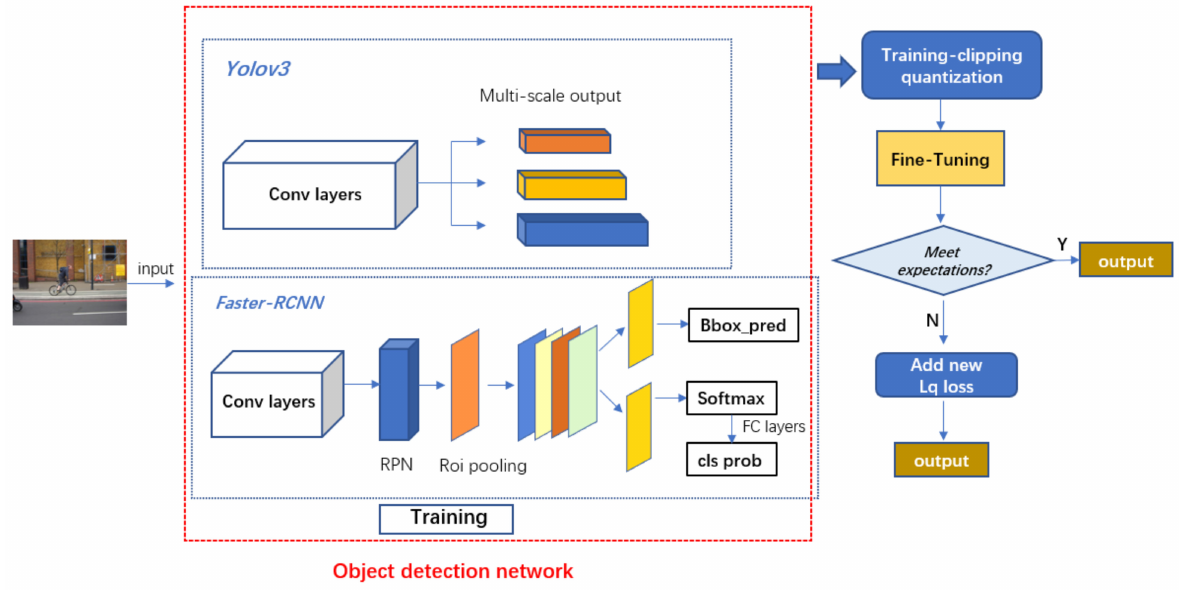
Figure 3. Architecture of the clipping-based post-training quantization